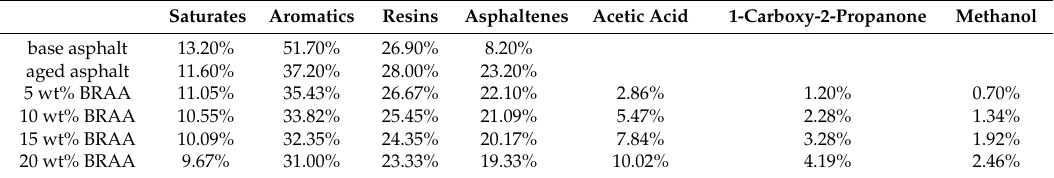
Table 1. Components of asphalt systems.